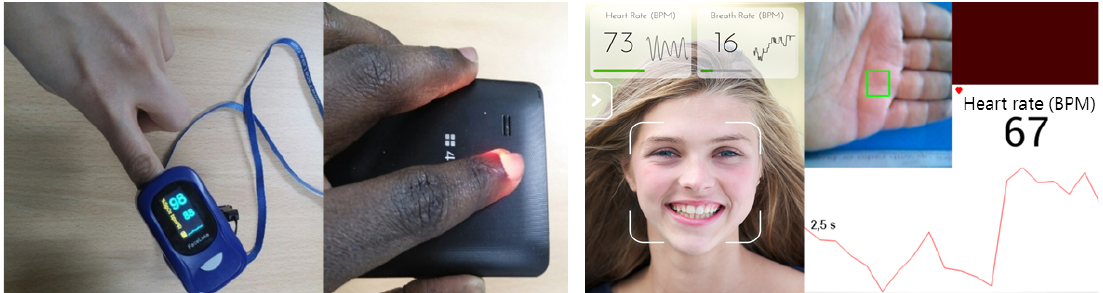
Figure 1. Heart-rate monitoring systems: ( left ), touch-based; ( right ),